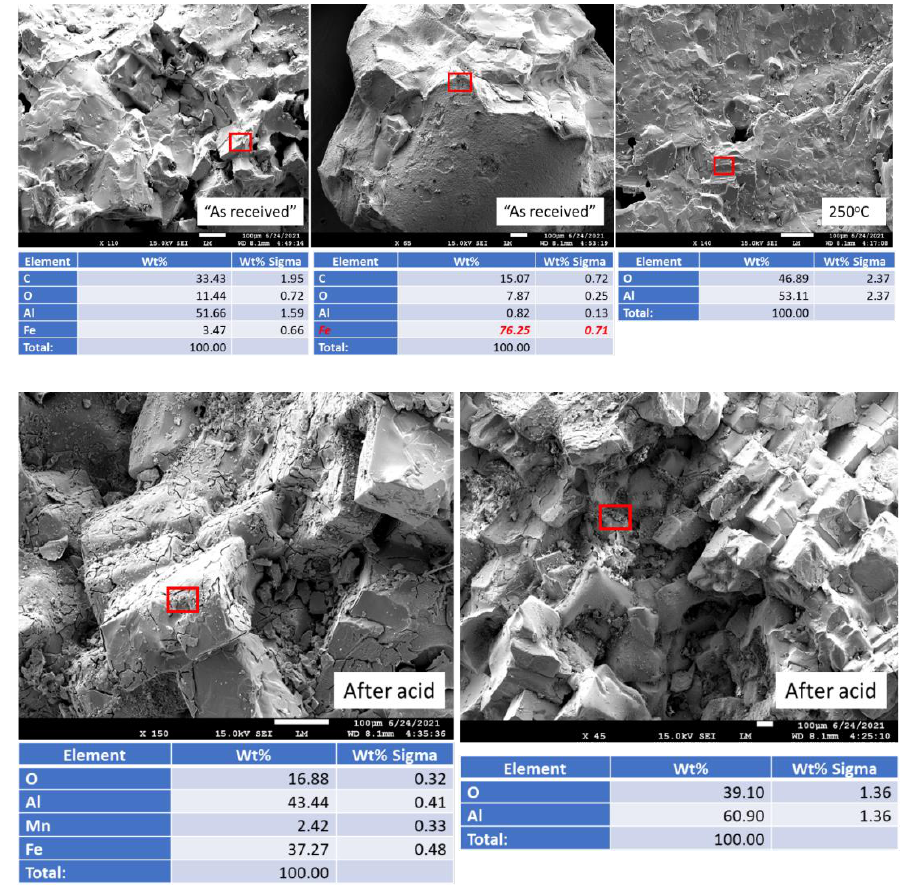
Figure 21. Photomicrographs of aluminum oxide samples with the elemental compositions of typical sites shown by the red boxes.